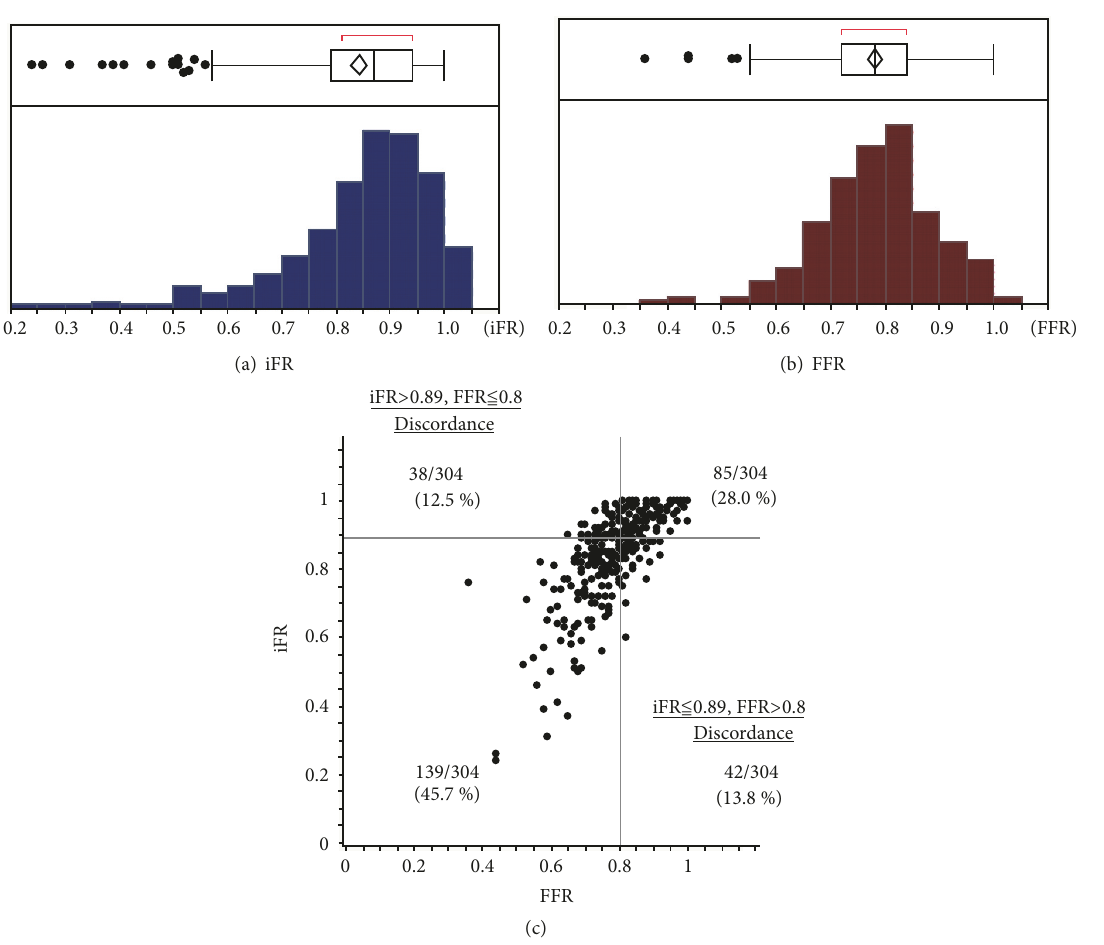
Figure 1: Distribution of the iFR (a) and FFR (b), and the scatter plot comparing the iFR and FFR (c). Discordance of iFR ≤ 0.89 and FFR > 0.8 was observed in 42 (13.8%) lesions. Discordance of iFR > 0.89 and FFR ≤ 0.8 occurred in 38 (12.5%) lesions. iFR: instantaneous wave-free ratio; FFR: fractional flow